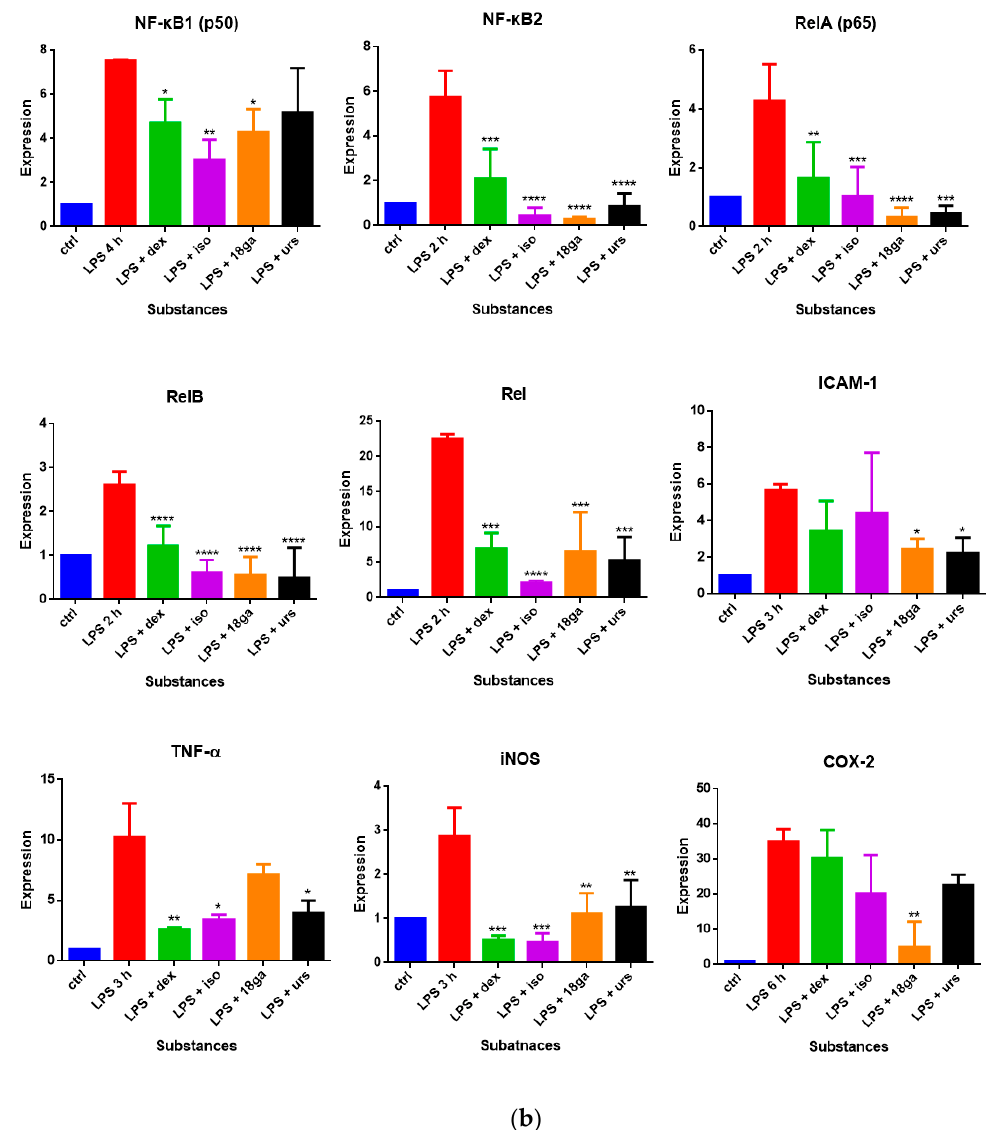
Figure 3. LPS induced NF- κ B subunit and NF- κ B-regulated gene expression changes. ( a ) NF- κ B subunit (NF- κ B1, NF- κ B2, RelA, RelB, and Rel) and NF- κ B-regulated gene (ICAM-1, TNF- α , iNOS, and COX-2) expression changes after 1 μ g/mL LPS stimulation for different times. ( b ) Effect of dex, iso, 18ga, or urs on NF- κ B subunit and NF- κ B-regulated gene expressions at the appointed times. The non-treated group was set as the control group (1.00). The results are expressed as the mean ± SD from at least three independent experiments. When p < 0.05, the difference was regarded as significant (* p < 0.05; ** p < 0.01; *** p < 0.001; **** p < 0.0001).